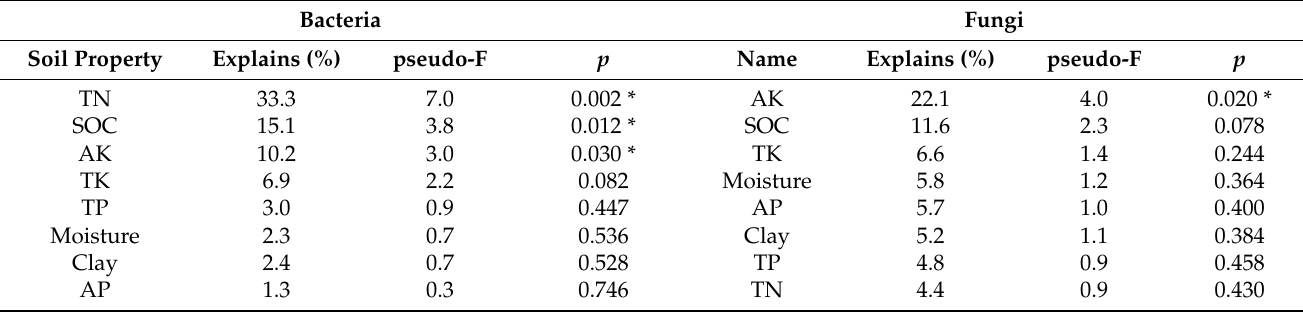
Table 2. Results of the summarized effects of explanatory